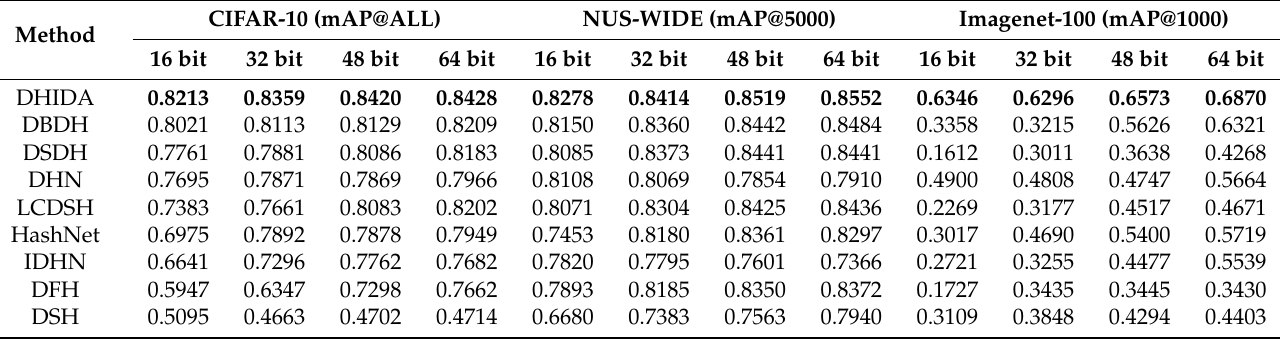
Table 3. mAP for different number of bits on three data